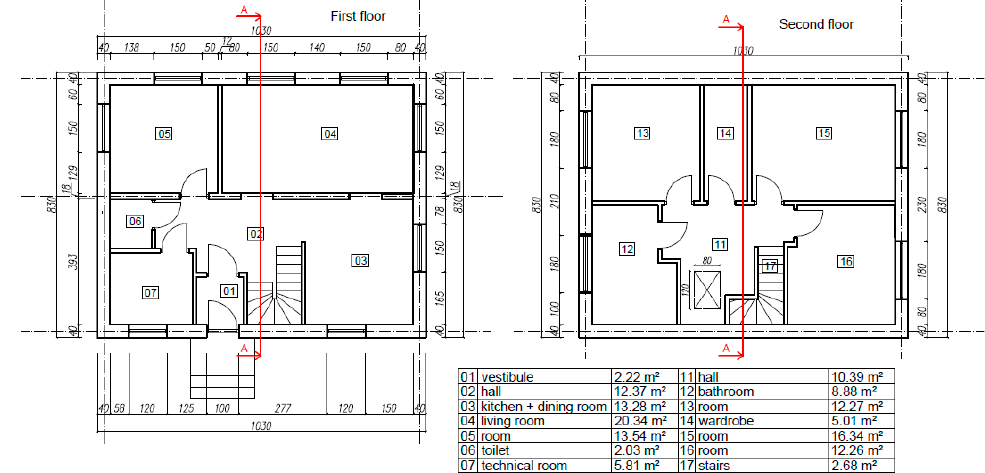
Figure 1. Schematic plan of the ground floor and the attic of the analyzed building (A–A means vertical section line).